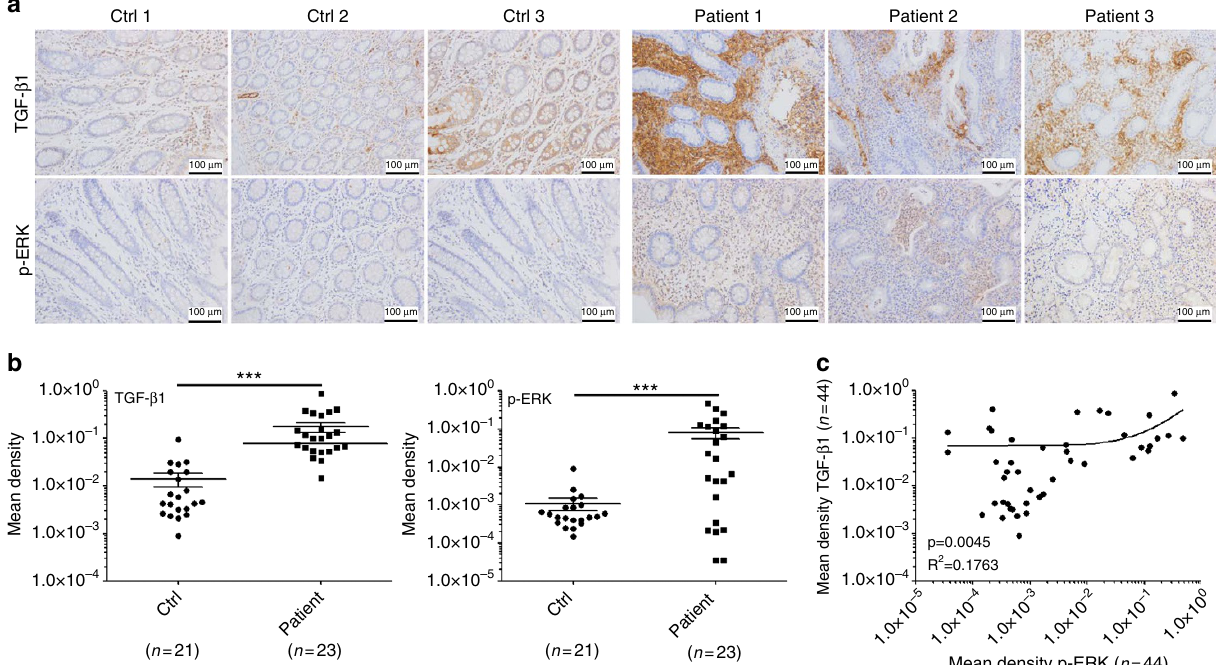
Figure 8 | TGF- b 1 and p-ERK levels in intestine tissues of IBD patients. ( a ) TGF- b 1 and p-ERK expression in intestinal tissues from IBD patients or healthy controls were detected using IHC. Data are three representative images from the results of IBD patients or healthy control people, respectively. ( b ) Five images were randomly captured from each IHC section. Images were analysed using Image-pro Plus 5.0, and the integrated optical densities of TGF- b 1 and p-ERK were statistically analysed. Data are presented as the mean ± s.d. ( n ¼ 21 in Ctrl group; n ¼ 23 in patient group). P values were generated by unpaired Student’s t -test using GraphPad Prism 5 (*** P o 0.001). ( c ) The correlation between expression of TGF- b 1 and p-ERK in intestine tissues was analysed by Spearman correlation analysis using GraphPad Prism 5 ( n ¼